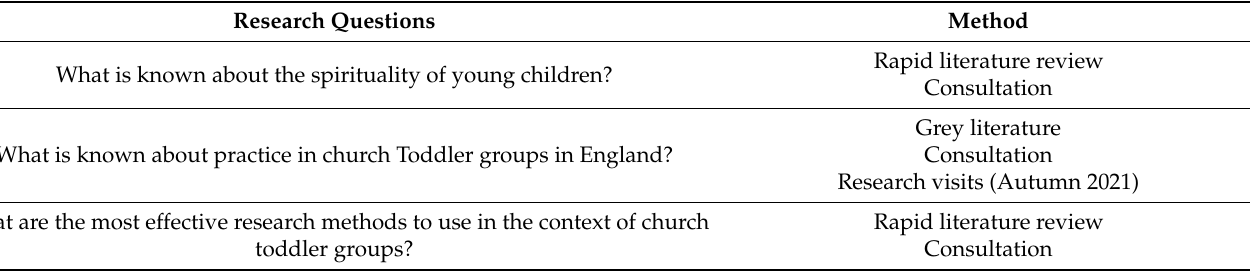
Table 1. Scoping study research questions and